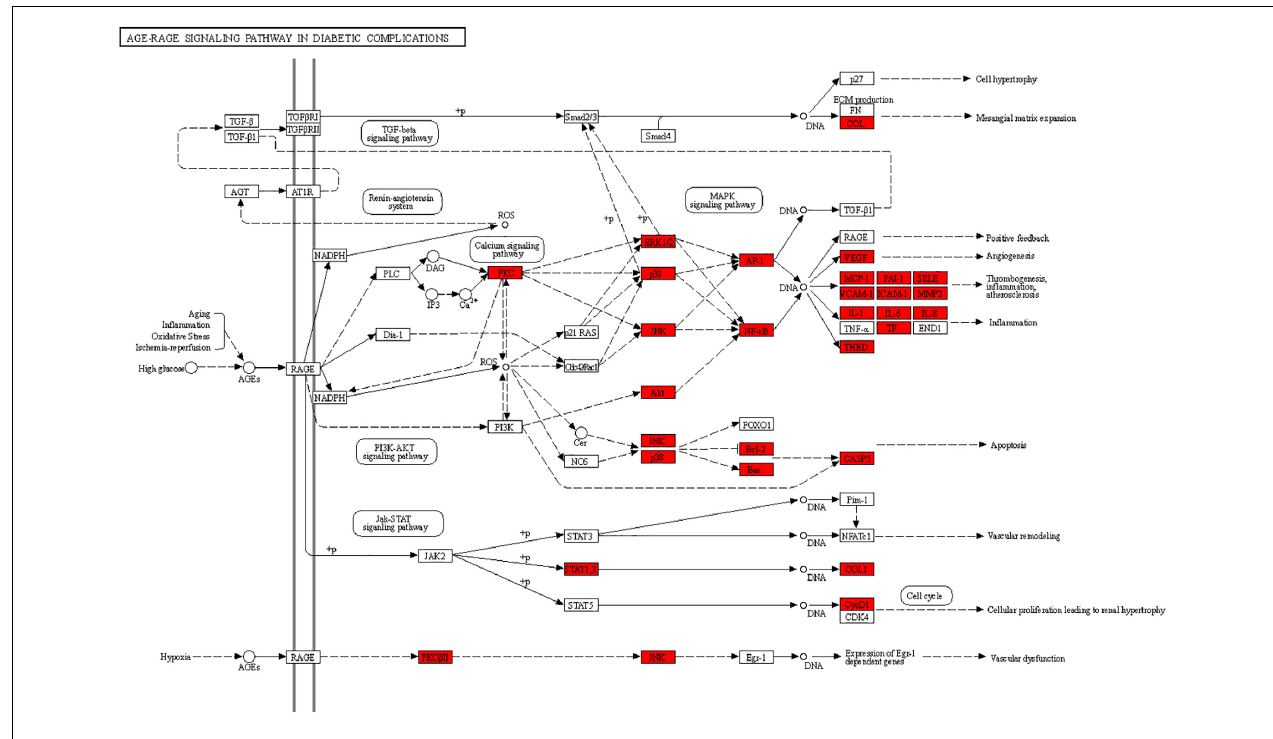
FIGURE 6 | The AGE-RAGE signaling pathway.